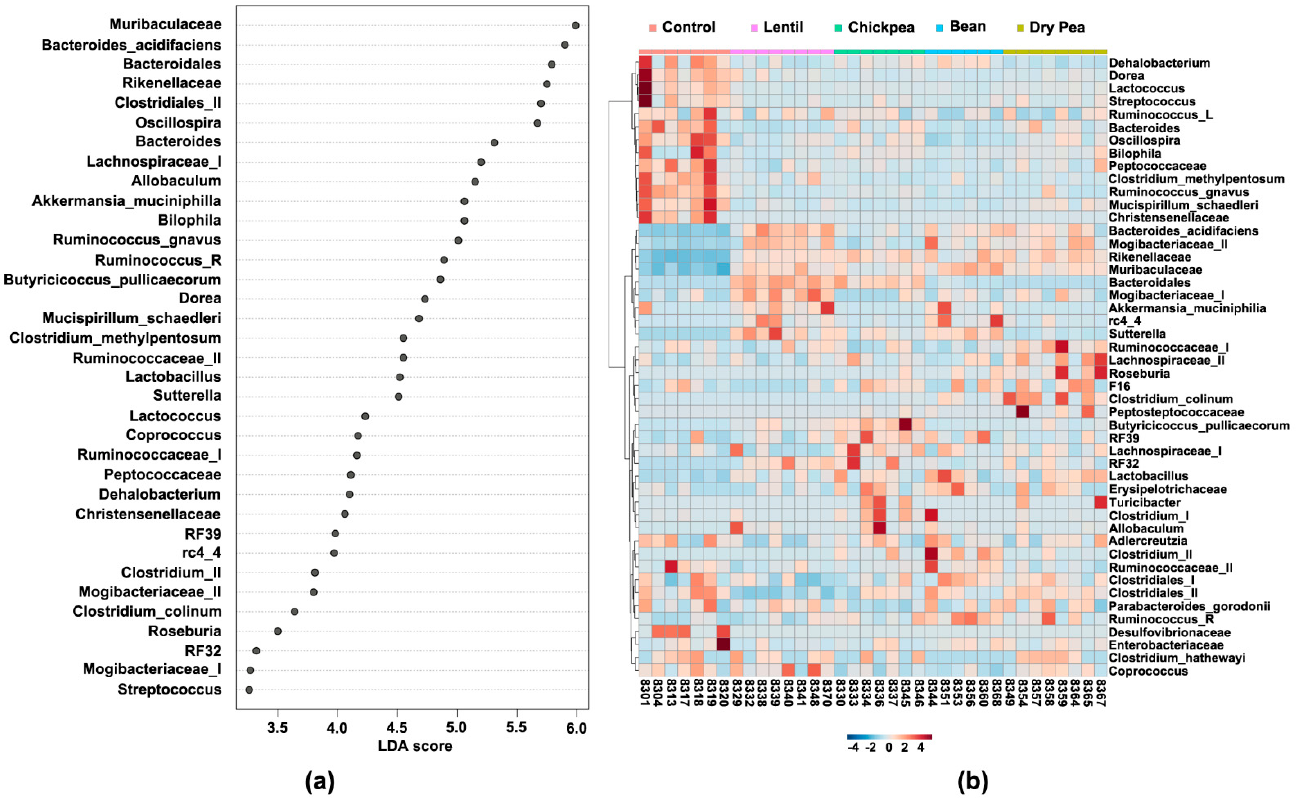
Figure 6. Differential abundance analysis of cecal microbiota across the diet groups: ( a ) The linear discriminant analysis (LDA) of effect size (LEfSe) between the diet groups at the feature level. All represented bacteria were statistically significant (LDA score > |2.0|); ( b ) Heatmap representing hierarchical clustering analysis results at the feature level. Clusters were organized by the diet group factor using Ward’s algorithm and Minkowski’s distance measure. Table 3. Bacterial abundance changes across the diet groups compared with